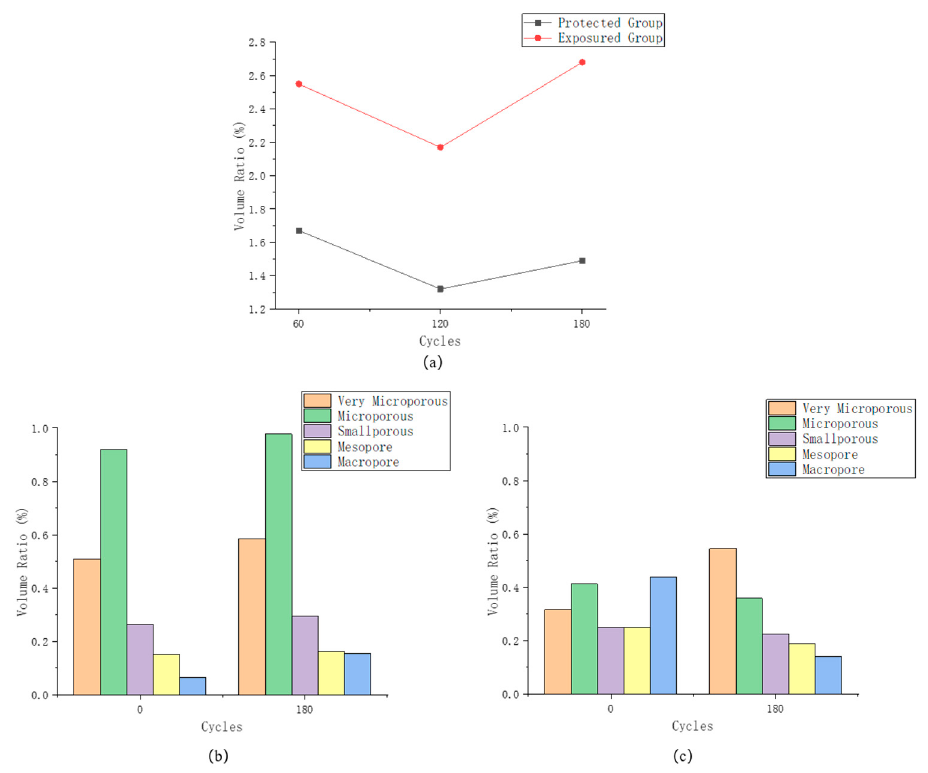
Figure 9. ( a ) Pore variation of specimens; ( b ) Pore composition of exposed group; ( c ) Pore composition of specimens of protected group.